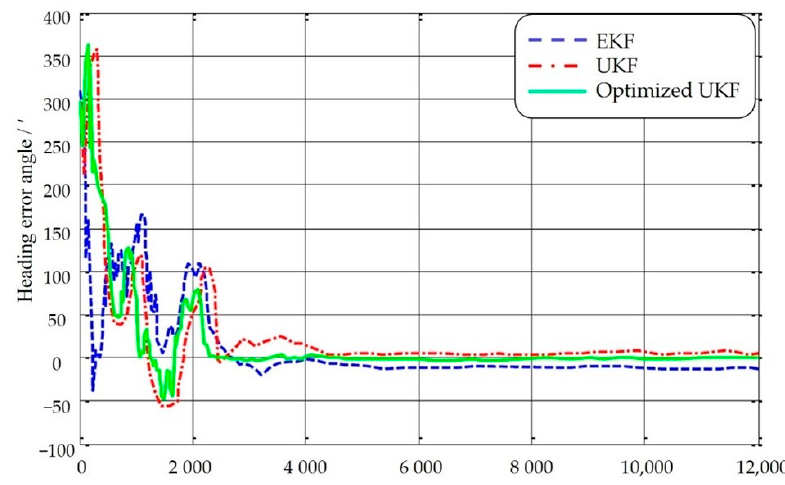
Figure 6. Filtering results of heading error angle.